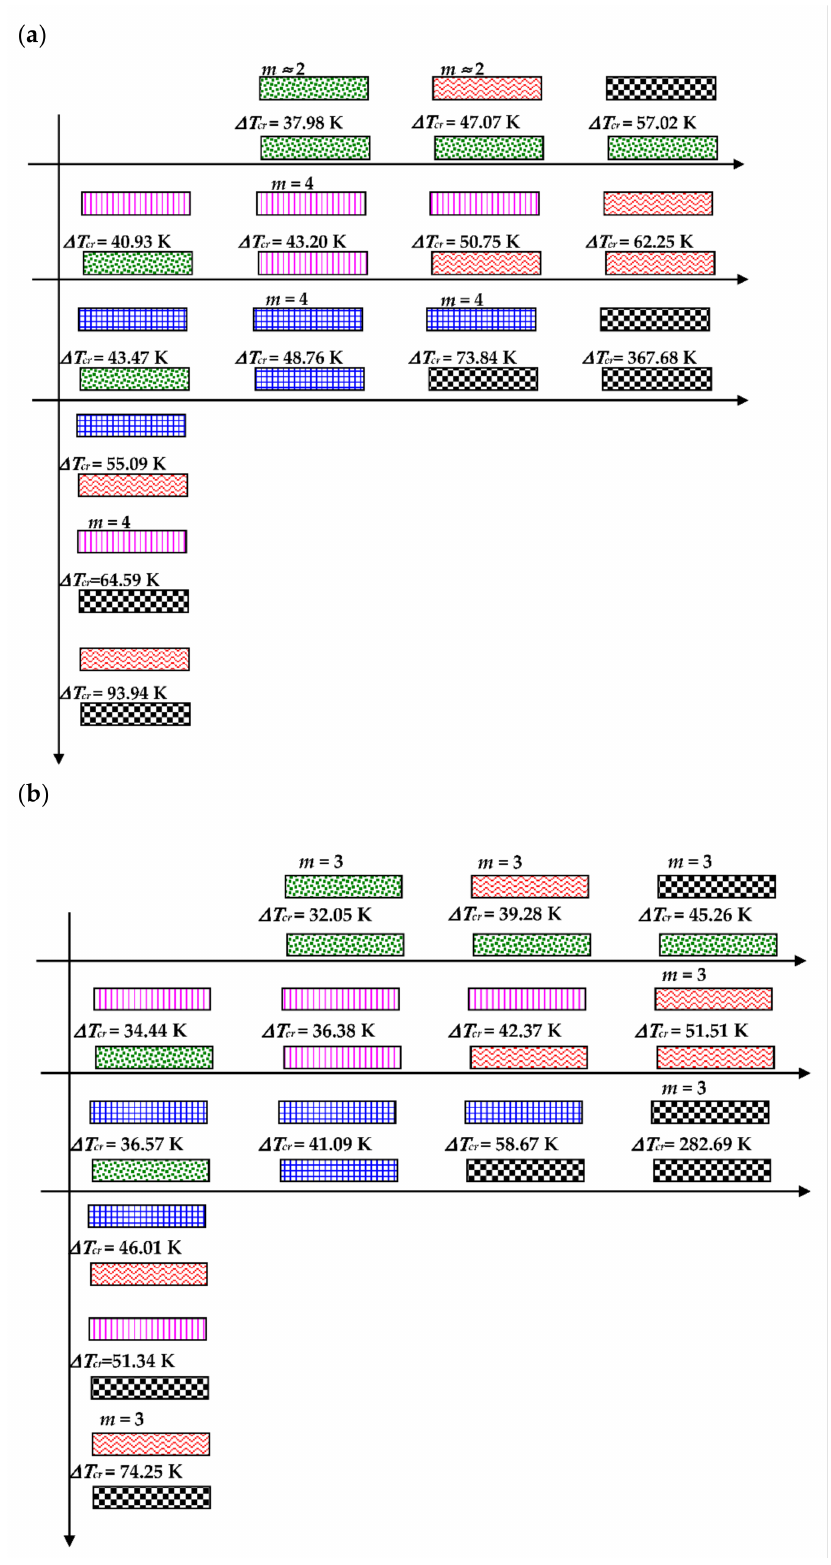
Figure 4. Distribution of the values of critical, temperature differences ∆ T cr depending on the form of the structure failure for a thermally isotropic plate subjected to a positive (a ), negative ( b ) temperature